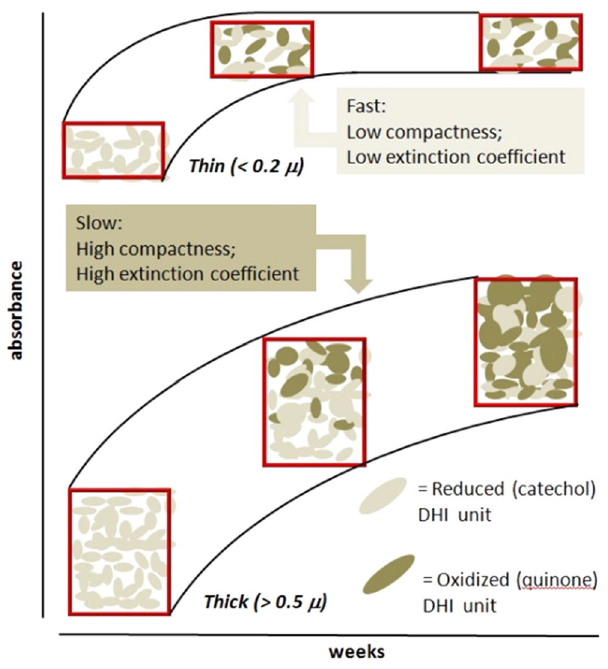
Figure 5. Pictorial view of DHI-unit oxidation and reorganization within melanising films of different thickness. Absorbance variation with time is associated whit the progress of unit oxidation in the